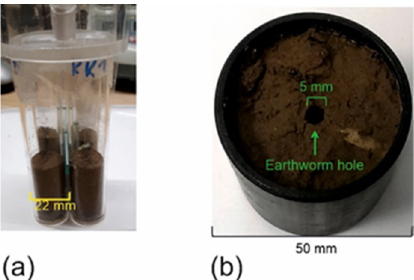
Figure 8. Test samples and soil core. ( a ) Sample S3 consisting of four 22 mm x 100 mm cuvettes filled with sandy loam soil and three reference standard 5 mm NMR tubes. ( b ) Sample S4: Soil core from Selhausen test site in a 100 cm 3 PVC cutting cylinder (silt-loam).